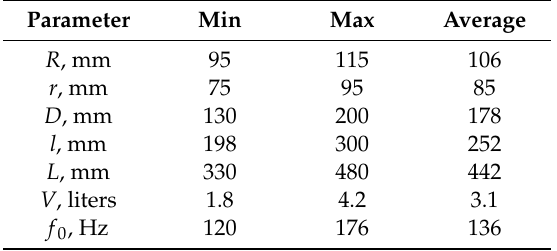
Figure 8. The resonator in the Rachmaninov Hall ( a ), its dimensions ( b ) and distribution of the resonance frequencies ( c ). Table 1. Parameters of the resonant vessel in the Rachmaninov Hall.